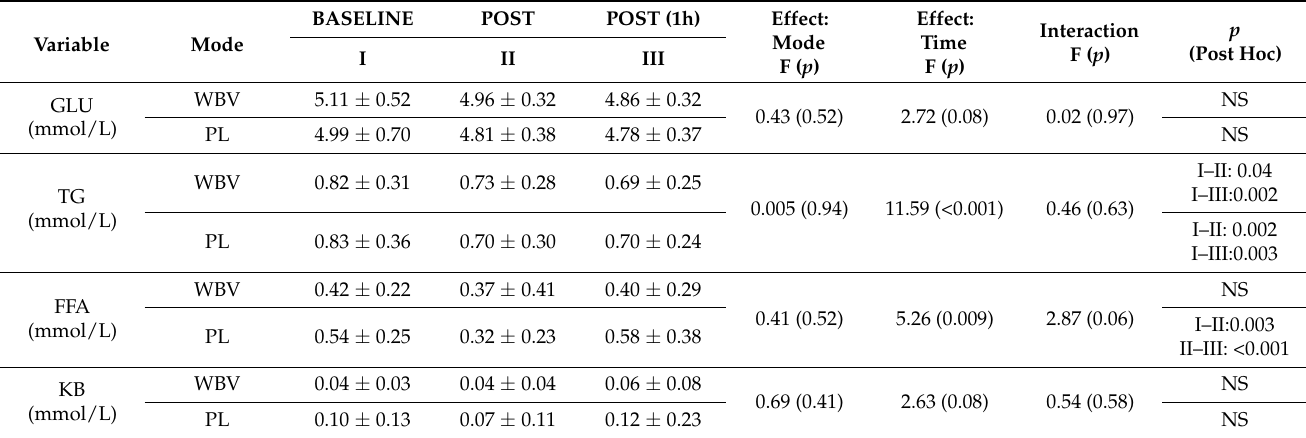
Figure 4. Changes in carbohydrate (CHO) utilisation pre- (baseline), during (treatment) and post- vibration (* significant change compared to baseline in WBV group). The data are presented as mean and 95% CI. Table 2. Effects of vibration on biochemical